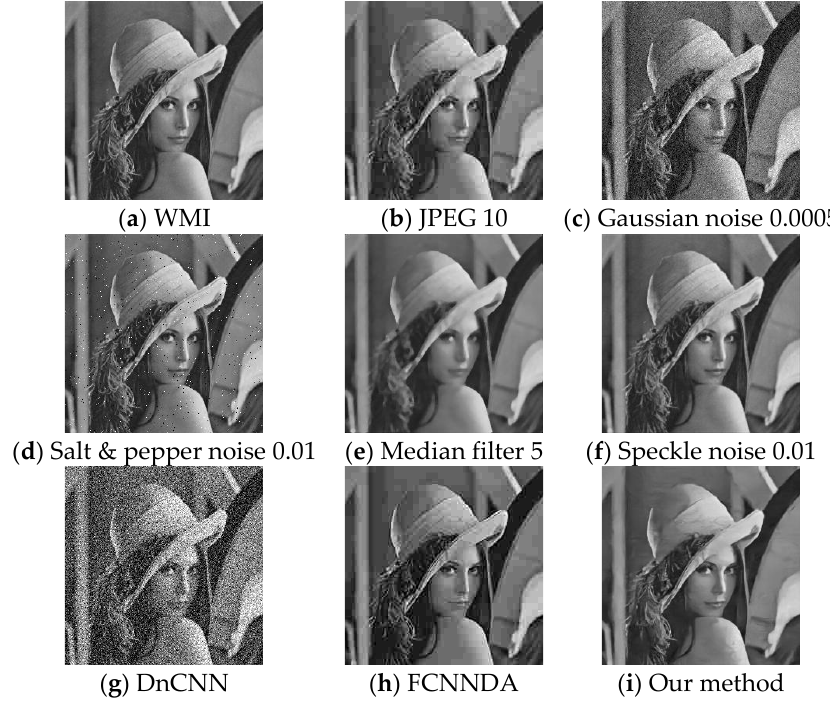
Figure 7. Comparison of AWMIs after applying different attacks to WMIs; the watermark size is 8 × 8.